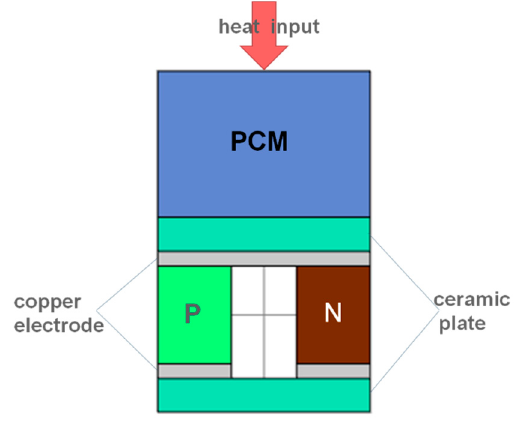
Figure 2. Thermoelectric energy storage structure.